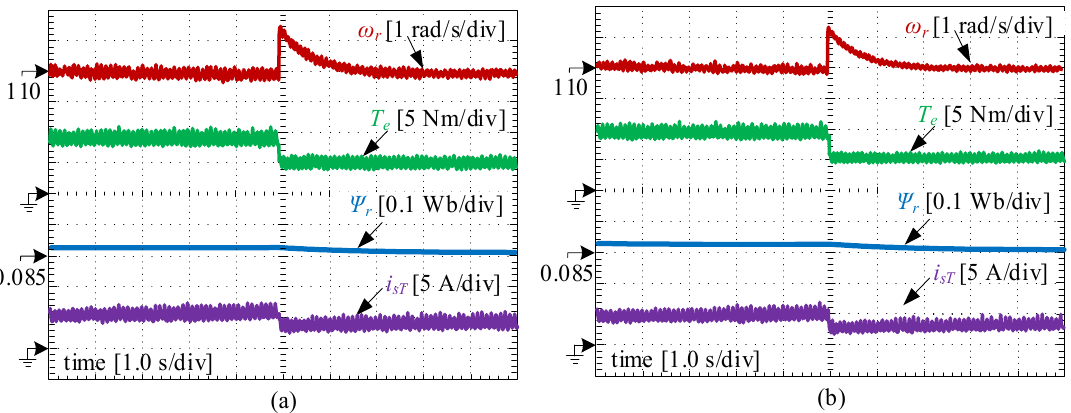
Figure 12. HIL testing results with different weighting factors. ( a ) Performance of traditional FCS-MPTC with fixed PI parameters and fixed weighting factor. ( b ) Performance of proposed FCS-MPTC with fixed PI parameters but adaptive weighting factor.